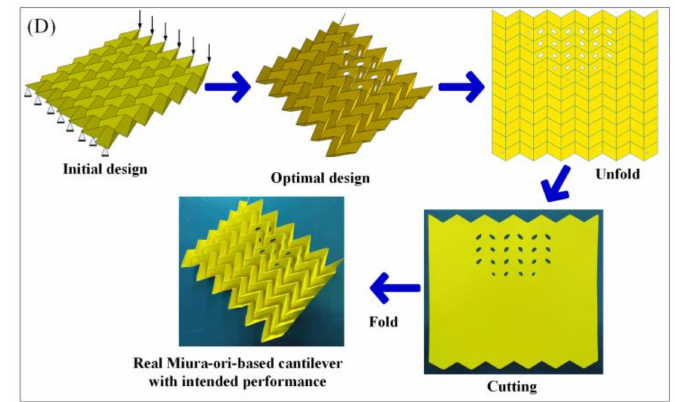
Figure 5. ( A ) Optimal designs for the Miura-ori-based cantilever under various constraints; ( B ) the corresponding displacements of the optimal solutions (unit: mm); ( C ) the corresponding stress distributions of the optimal solutions (unit: MPa); and ( D ) applying the proposed framework to the Miura-ori-based